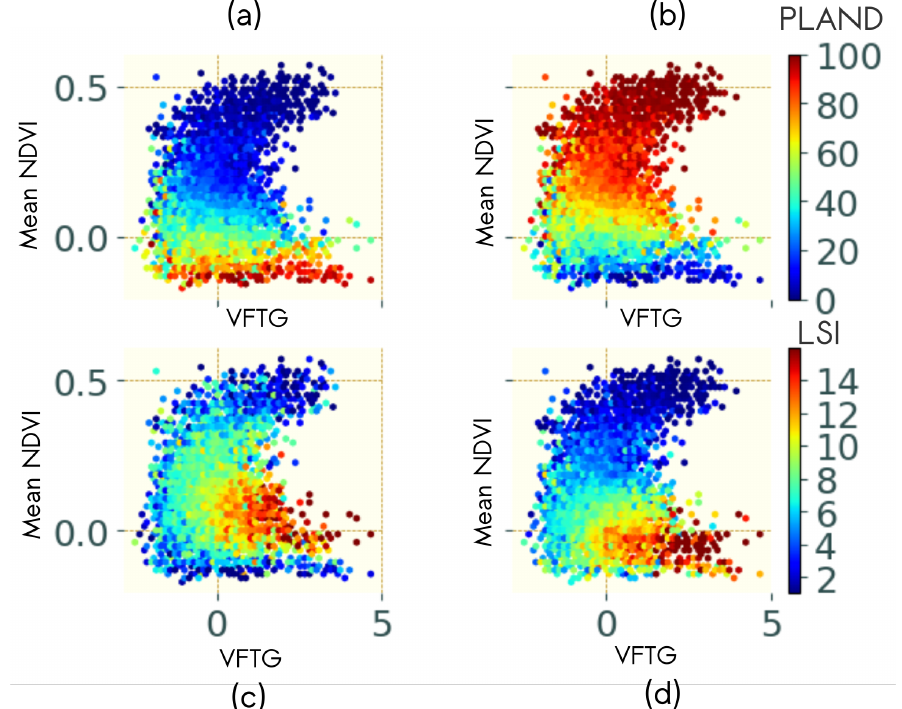
Figure 5. PLAND ( a , b ) and LSI ( c , d ) distribution for ( a , c ) the grouped bare soil and herbs strata and ( b , d ) the grouped low and high ligneous strata on the 2D plane defined by the VFTG and mean NDVI computed on airborne